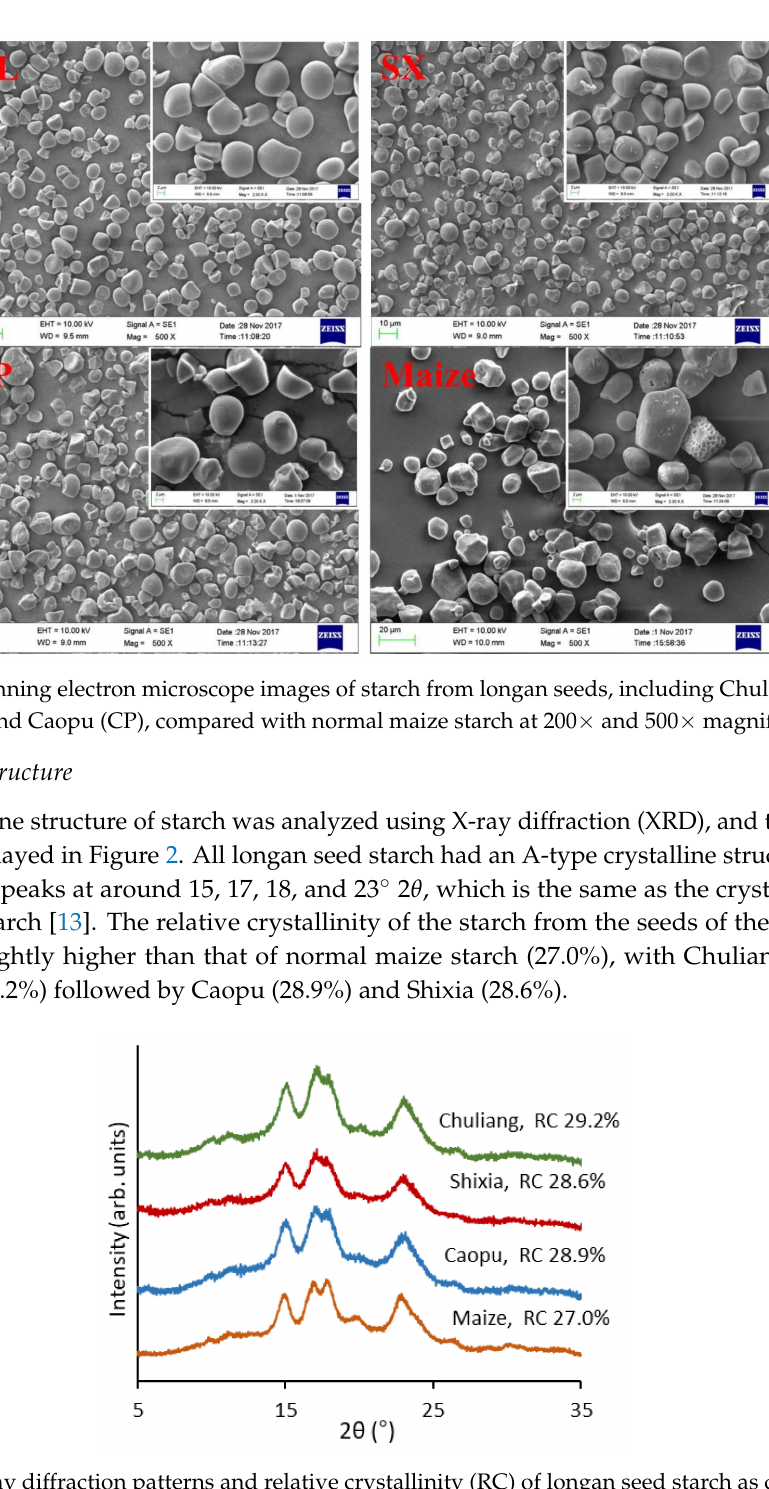
Figure 2. X-ray diffraction patterns and relative crystallinity (RC) of longan seed starch as compared with normal maize